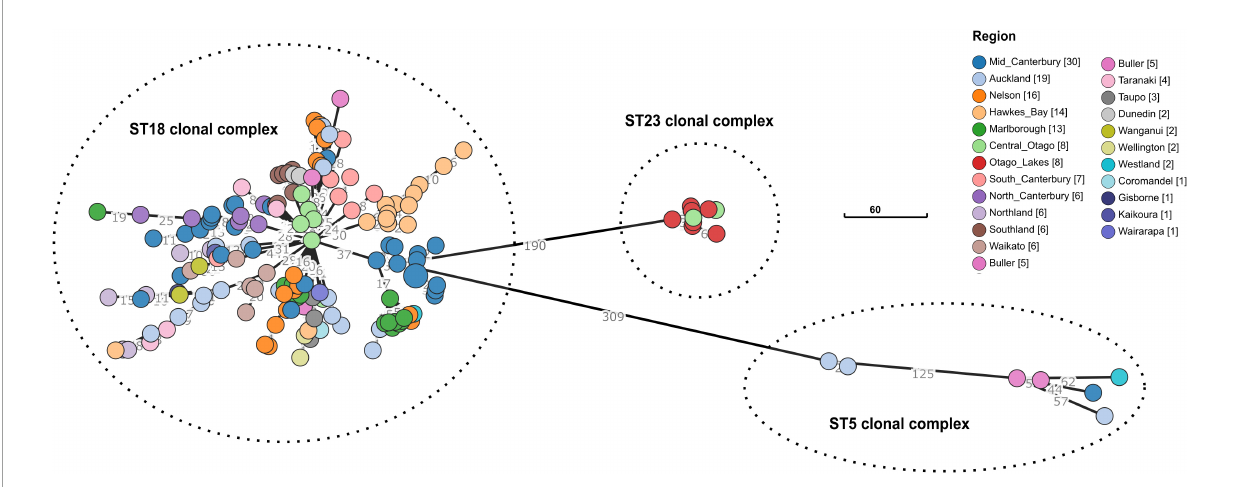
FIGURE2 Minimum-spanning of the core genome multilocus sequence types (cgMLST) for n = 163 Paenibacillus larvae in New Zealand, by region. Regions are color coded, with the tally of isolates shown in square brackets. The dashed lines delimit three clusters, each representing one of the 7-gene MLST we found in this study (viz., ST5, ST18, and ST23). The total number of allele differences between each node are shown on the branch lines. Scale bar shows 60 allele